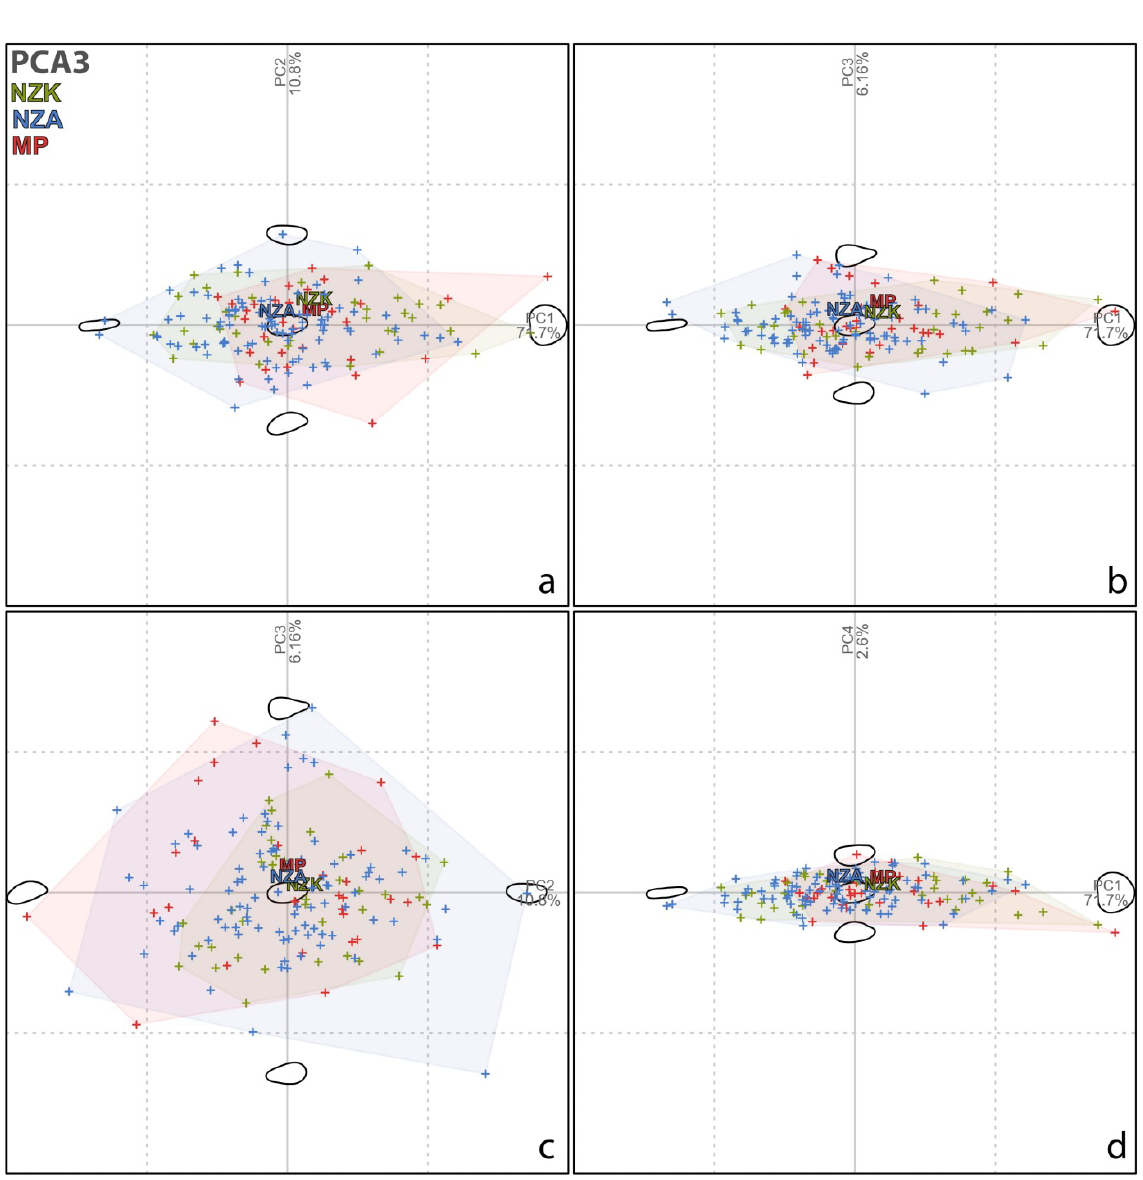
Figure 13. PCA3 - Plot of the PCA scores of the first four PCs. PCA is realised on EFA coefficients of the whole